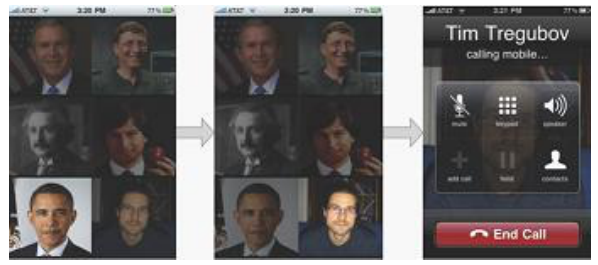
Fig. 5. Contacts flash, one by one, detecting the user visual focus. A phone call is made to the one choosed. Source: [2].